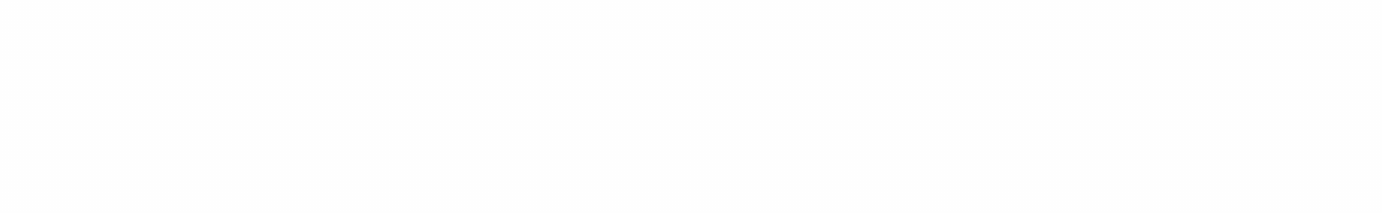
FIGURE 12 Bifurcation diagram of K without noise (param- eter: Figure 16 is the bifurcation diagram of Y with respect to the changes of the parameter c without noise effects, and Fig. 17 shows the largest Lyapunov exponent in this case. The equilibrium point is stable when c is small, but it becomes unstable and two period cycle becomes stable when c exceeds 2.25. Then, the period-doubling bifurca- tions occur rapidly, and the behavior of the system becomes